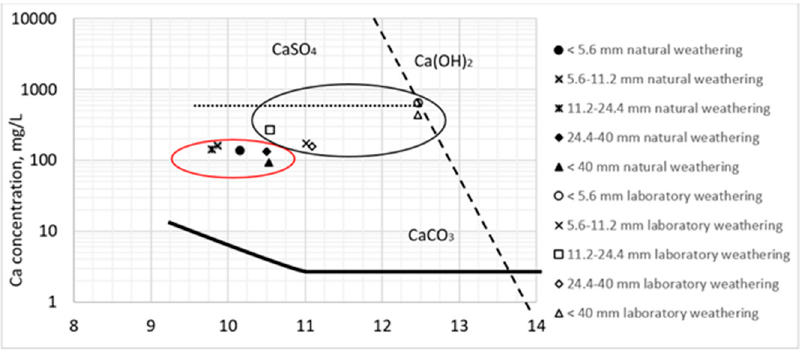
Figure 8. Changes in calcium solubility and pH during 6 months of natural weathering of BA eluates as a function of particle size.